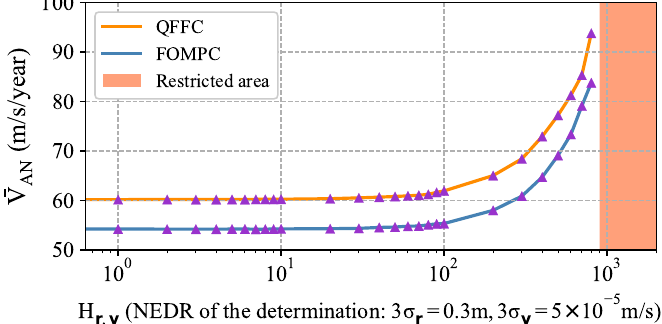
Figure 16. The results of Monte Carlo simulations for the determination error of different